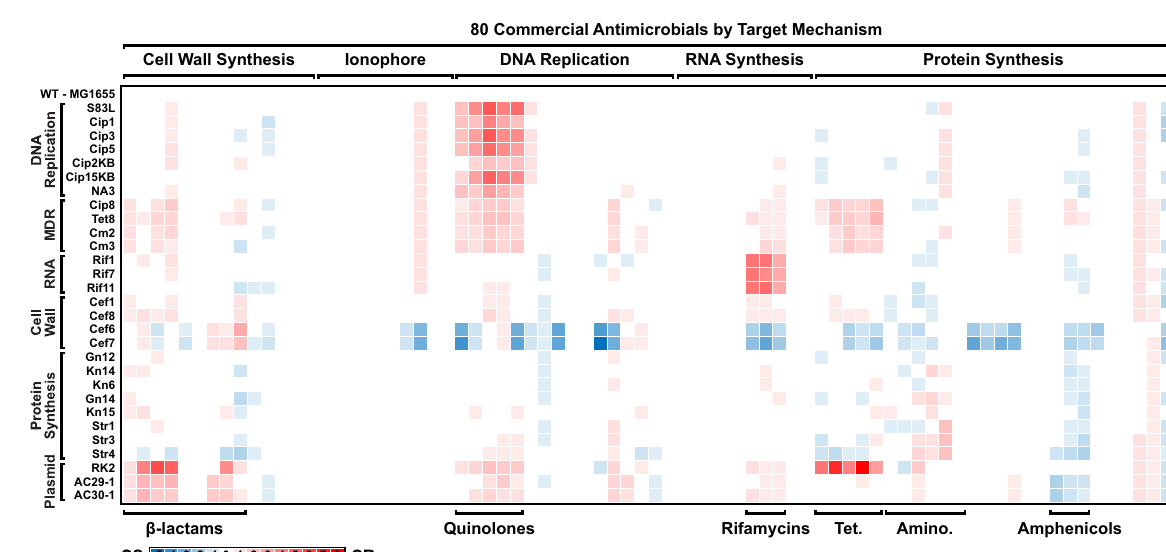
Fig. 2 | Collateral sensitivity pro fi ling (CSP) of 80 commercial antimicrobials against a drug-resistant E . coli target panel. Legend: white=no change in Log 2 MIC compared to wildtype; red=increase in Log 2 MIC compared to wildtype (resistance); blue=decrease in Log 2 MIC compared to wildtype (collateral sensi- tivity).Antimicrobialsarecategorizedalongthehorizontalaxisbytheirmechanism ofaction(top)andspeci fi callybytheirdrugclasses(bottom).Mutant E.coli strains